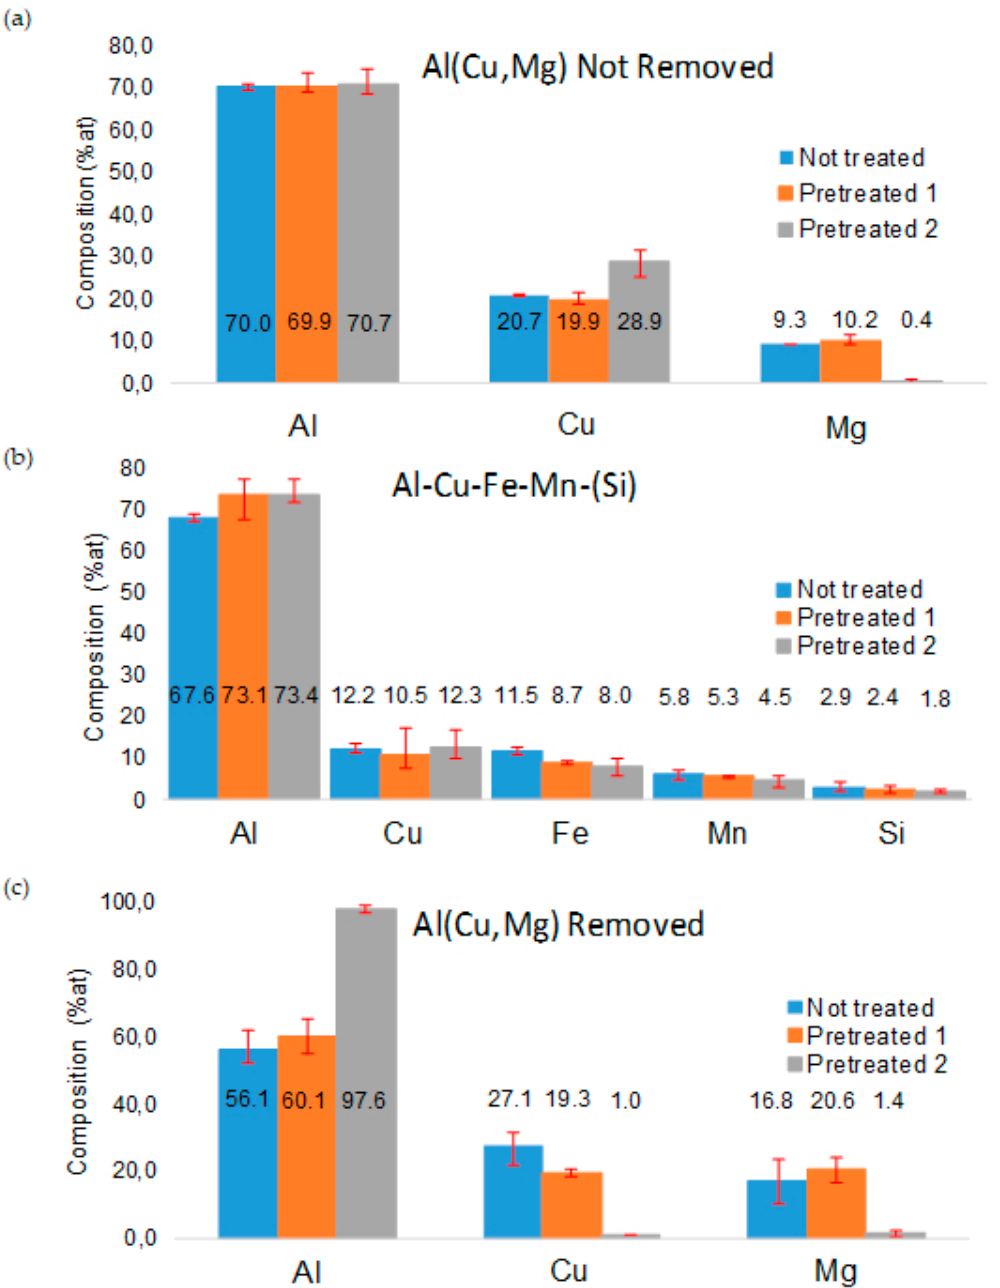
Figure 5. Bar plots of semi-quantitative analysis of ( a ) Al(Cu,Mg) not removed, ( b ) Al-Cu-Fe-Mn-(Si) and ( c ) Al(Cu,Mg)